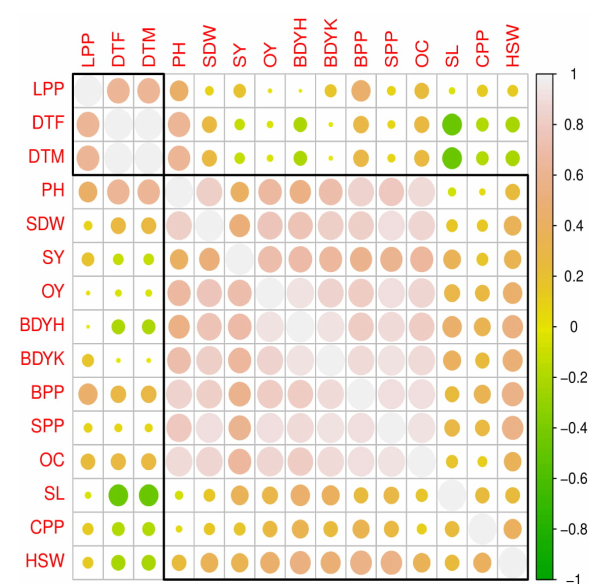
FIGURE 3 | Pearson correlations among different parameters of caster bean studied in this experiment. Different abbreviations used in this figure are as follows: PH, plant height; SL, spike length; BPP, branches per plant; SPP, spike per plant; SDW, spike dry weight; DTF, days taken to 50% flowering; CPP, capsule per plant; HSW, hundred seed weight; SY, seed yield; DTM, days taken to maturity; OC, oil content; OY, oil yield; BDY, biodiesel